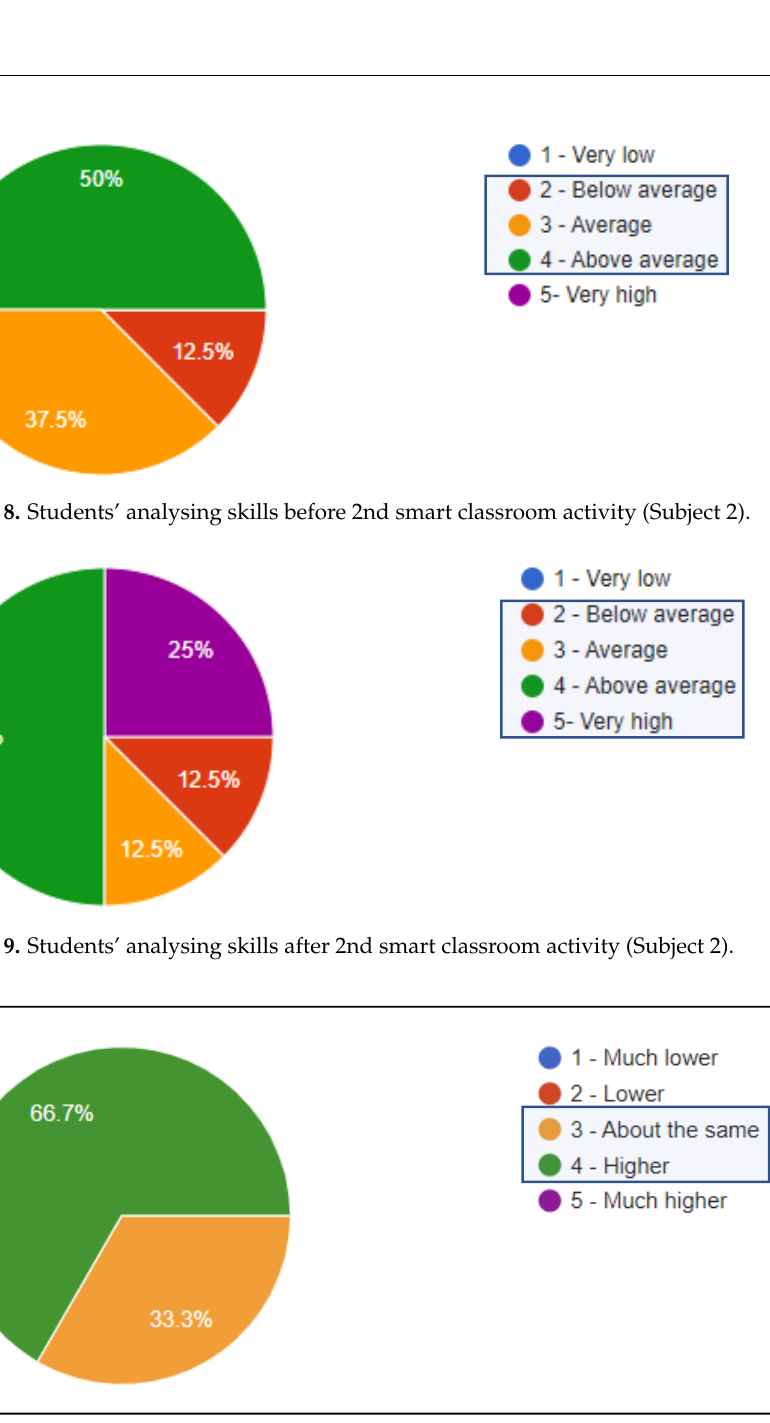
Figure 11. Students’ creating skills after experiential learning in smart classroom (Subject 1).